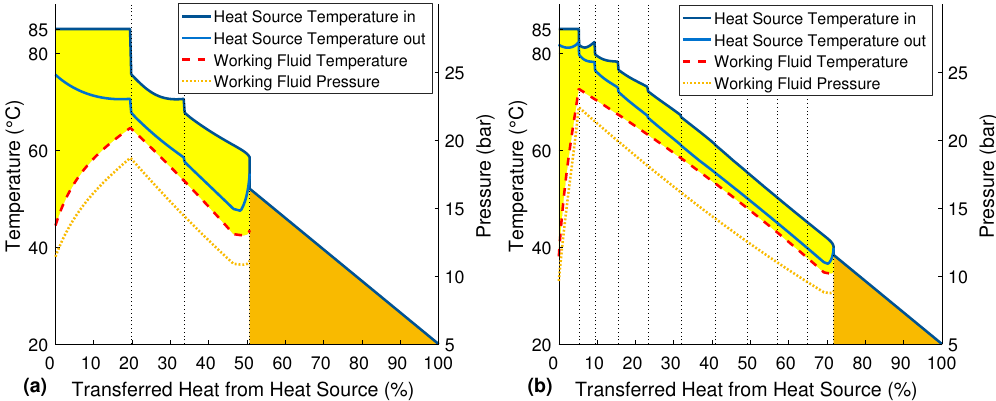
Figure 6. Quasi-continuous T-Q-diagrams of the Misselhorn cycle: ( a ) three heat exchangers; ( b ) ten heat exchangers.